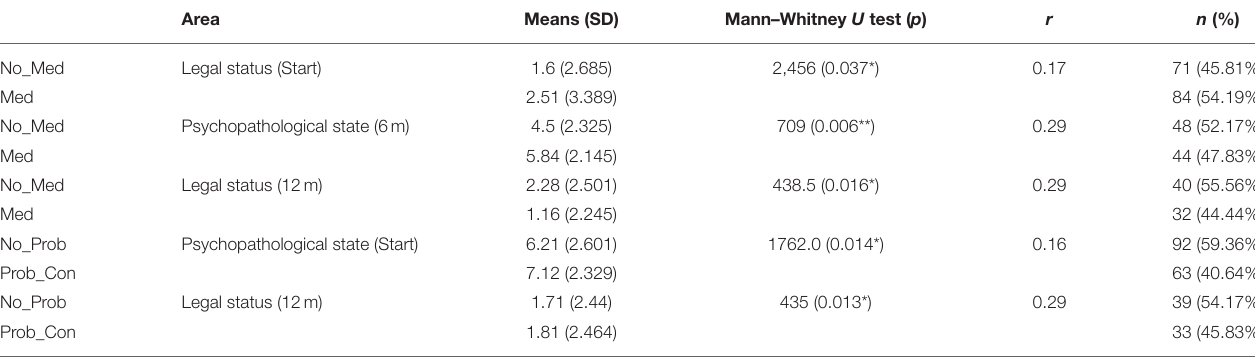
TABLE 8 | Differences by medication